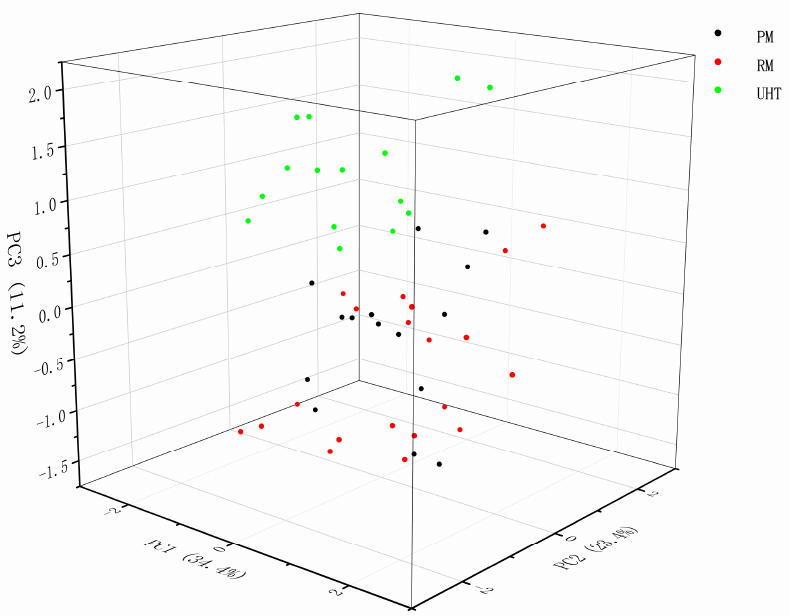
Figure 3. The PCA score plot for the composition of C18 FAs of raw milk ( n = 20), PAS milk ( n = 15), and UHT milk samples ( n = 15).